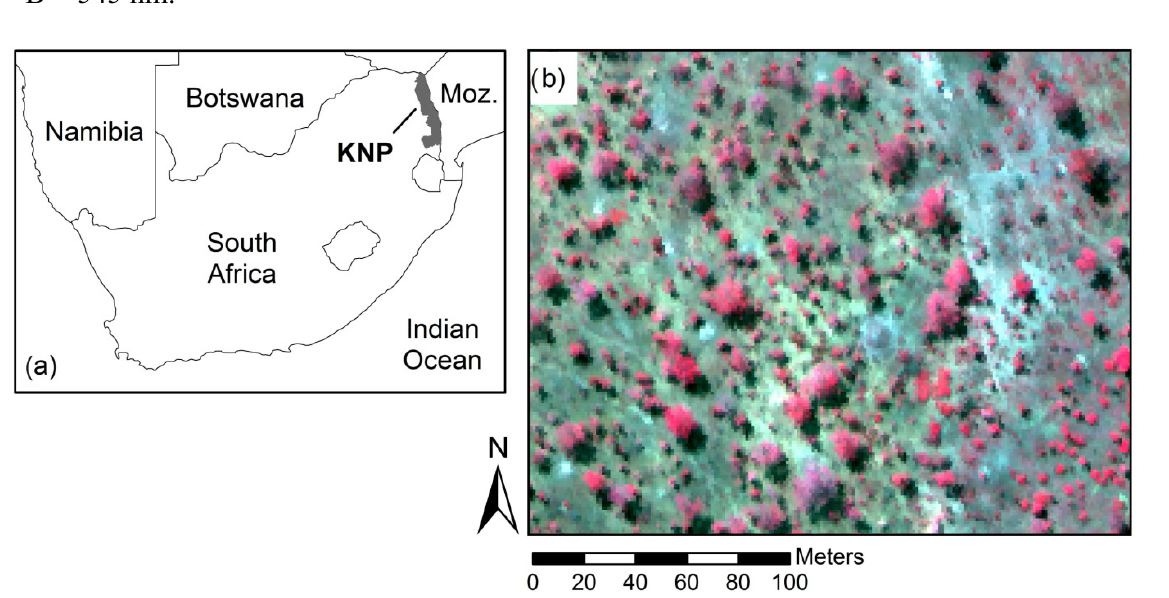
Figure 1. ( a ) Map showing the location of Kruger National Park (KNP) in South Africa. ( b ) A sample of the Carnegie Airborne Observatory (CAO) Alpha imagery obtained